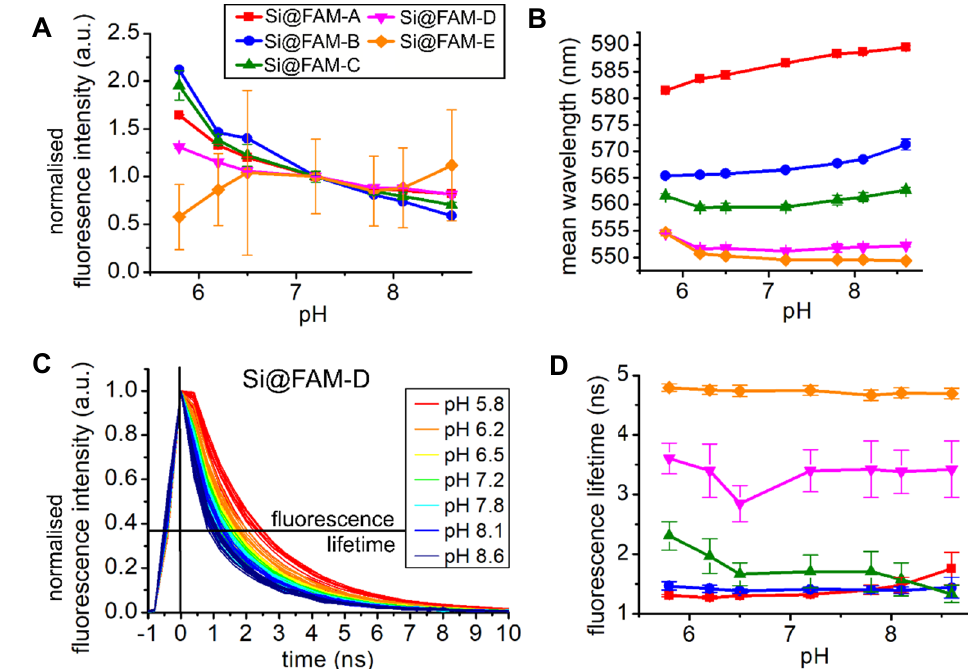
Figure 4. Response to pH of beads with varying loading density. Three series of measurements were taken over a range of physiological relevant pH from 5.8 to 8.6. The legend for (B), and (D) is placed in ( A ): ( A ) Changes in the fluorescence intensity with pH; displayed are the mean and its standard deviation across all cores. For reason of comparison, all fluorescence intensities are normalised to their value at pH 7.2. ( B ) Mean wavelength of the fluorescence spectra line shape with pH. ( C ) Normalised fluorescence decays of beads Si@FAM-C showing a decrease in lifetime with increasing pH. The spectral histograms are summed over the range 520 to 700 nm for each core, and the results for 10 cores at each pH are shown. ( D ) Fluorescence lifetime changes with pH for various bead loading densities.